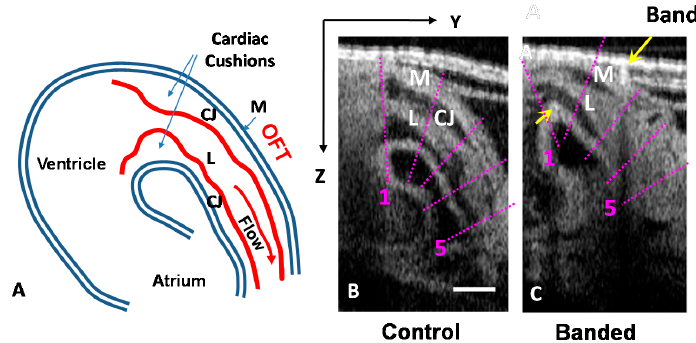
Figure 1. OCT images of the chick heart OFT. ( A ) Schematic of chicken heart at HH18. Note that details of the lumen-wall interface (red line) are given only for the OFT portion of the heart; ( B ) Longitudinal section of a normal OFT during OFT myocardial contraction; ( C ) Longitudinal section of a banded OFT, yellow arrows pointing at the band. Overlaid purple lines show the locations (1 to 5) from which cross-sectional images were extracted from the 4D OCT images for further analysis. Scale bar = 200 µm. M: Myocardium; L: Lumen; CJ: Cardiac jelly, with cardiac cushions being thickenings of the CJ.